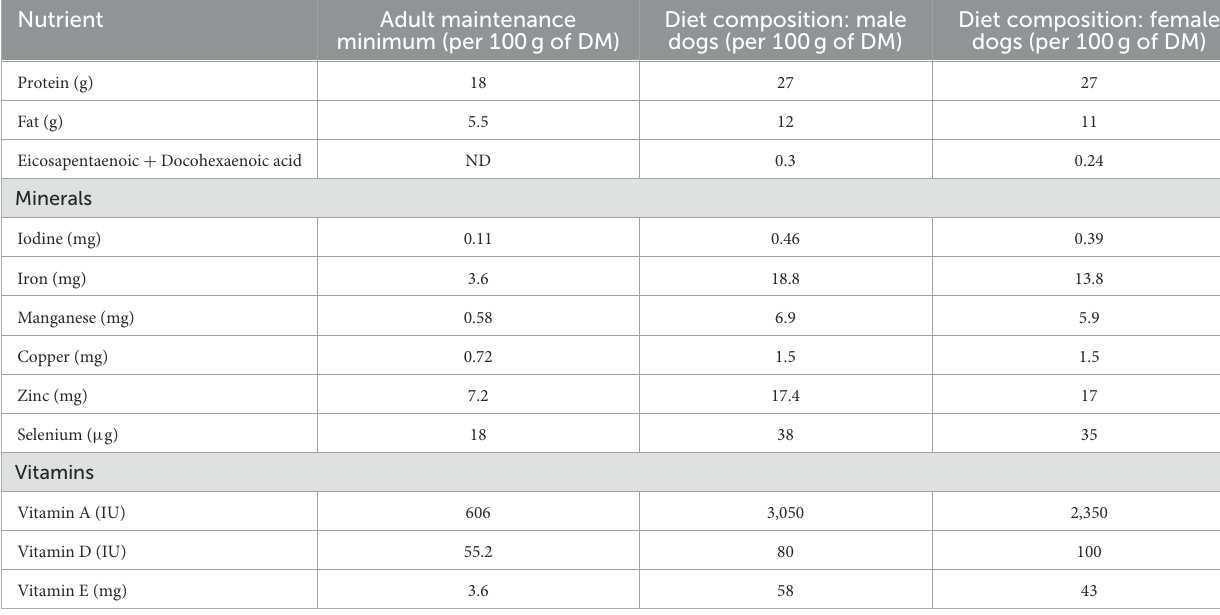
TABLE 1 Diet composition and recommended nutrient levels for dogs according to the European pet food industry federation guidelines (2020), based on metabolizable energy requirement of 110 kcal/kg 0.75 . Nutrient Adult maintenance Diet composition: male Diet composition: female minimum (per 100g of DM) dogs (per 100g of DM) dogs (per 100g of